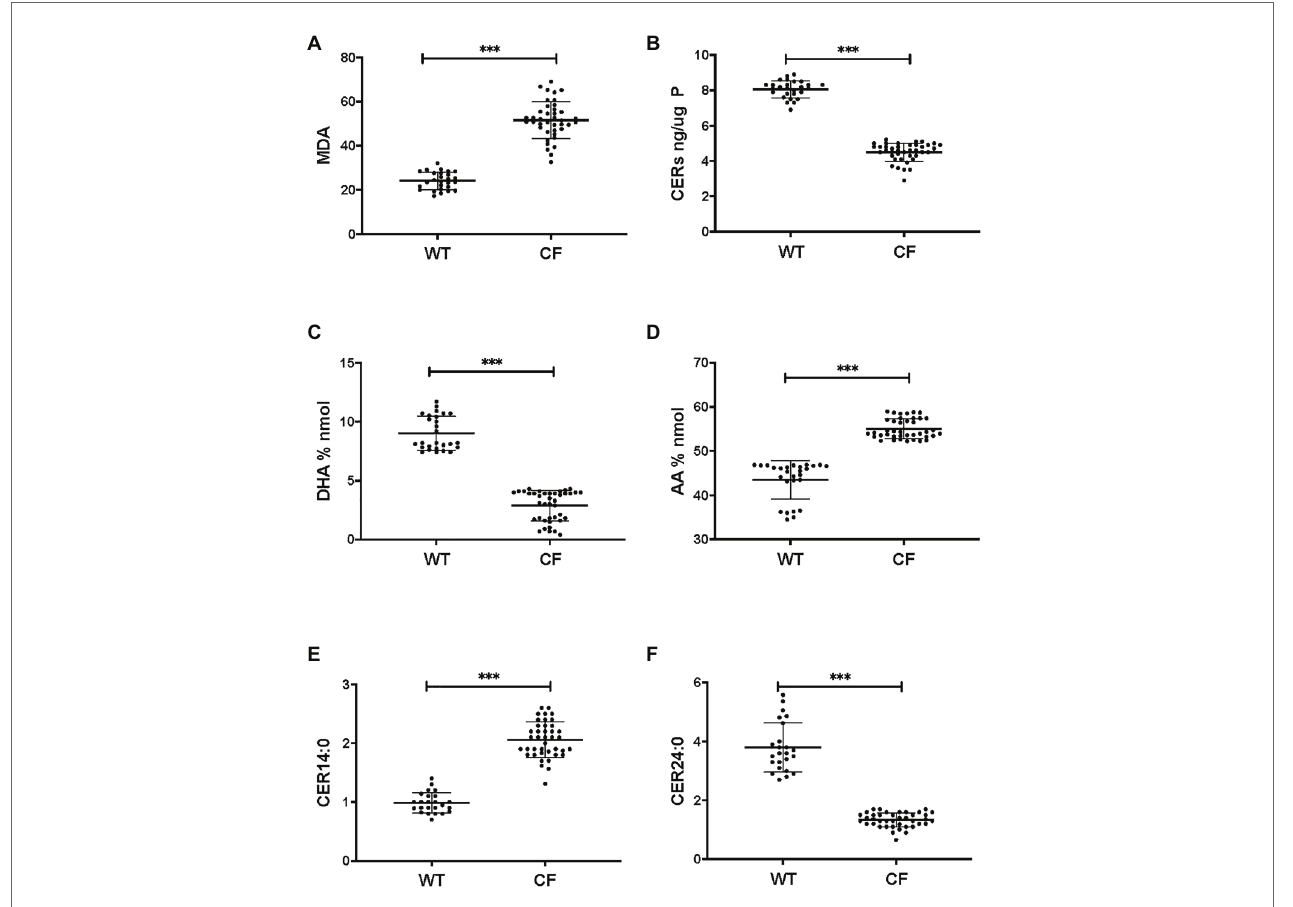
FIGURE 1 | Oxidative stress, ceramides, and abnormal lipid metabolism in CF human bronchial epithelial cells in ALI culture. CF HBEC-ALI from five different donors ( Table 1 ) compared to non-CF (WT, five different donors, see methods), were analyzed as described in methods. Data were merged from three separate experiments, comparing each donor in triplicate or quadruplicate in every experiment, data points are shown representing a single membrane (CF N = 40 filters, non-CF N = 25 filters). Horizontal bars represent average, error bars ± SD. (A) malondialdehyde (MDA) pmol/nmol fatty acid. (B) Total ceramides in CF HBEC-ALI. (C) Docosohexaenoic acid (DHA) levels (% nmol total fatty acids) are strongly reduced in CF HBEC-ALI compared to WT. (D) arachidonic acid (AA) levels (% nmol total fatty acids). (E) Long-chain ceramide (CER14:0). (F) Very long-chain ceramide (CER24:0) expressed as pmol/nmol phosphate. Statistical analysis (unpaired T -test) was performed with grouped averages (CF vs. Non-CF) for each different